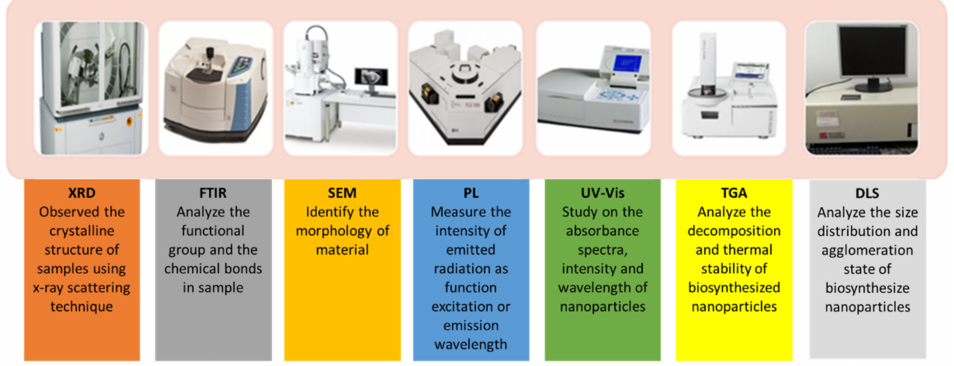
Figure 8. Methods of characterization of biosynthesized